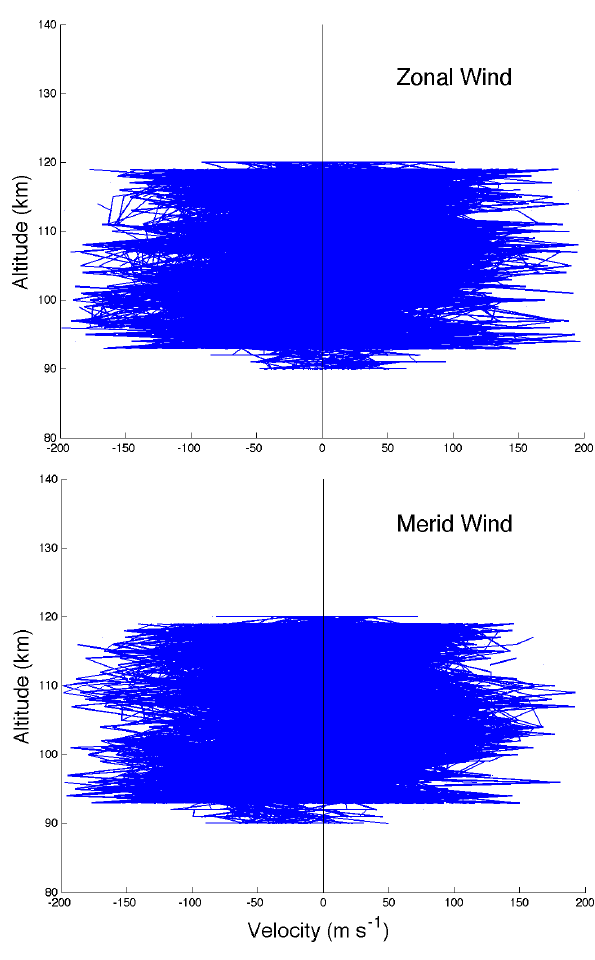
Fig. 5. Superposition of the zonal and meridional wind profiles ob- tained with the Arecibo Observatory incoherent scatter radar during the Lower Thermosphere Coupling Study observation periods.